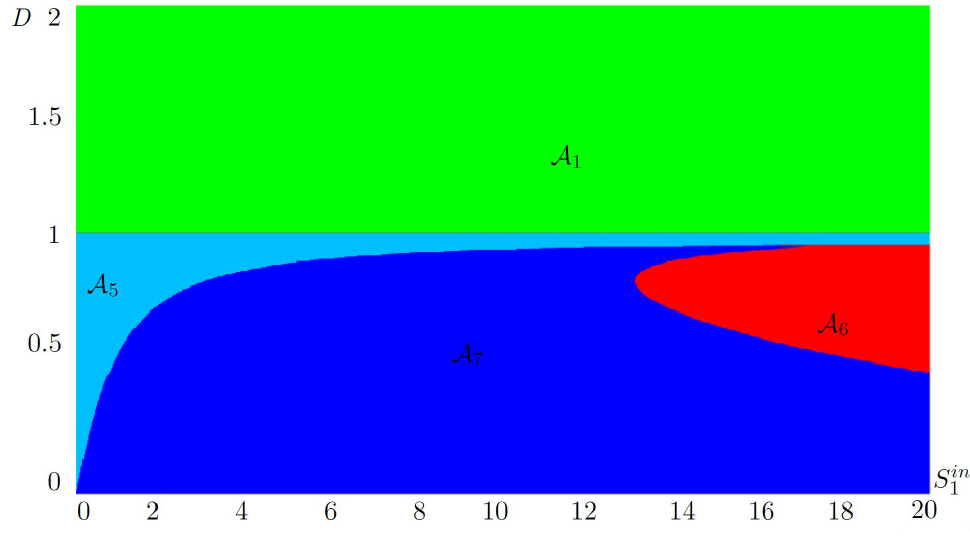
Figure 4. The operating diagram for S in